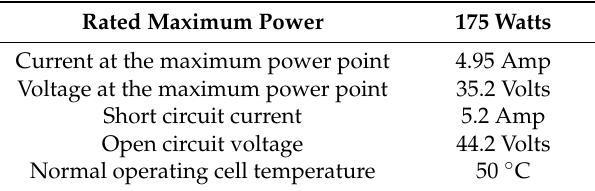
Table 1. The details of the characteristics of the solar panel can be found in [36]. Table 1. The parameters of the PV panel STP175S-24/Ac at STC